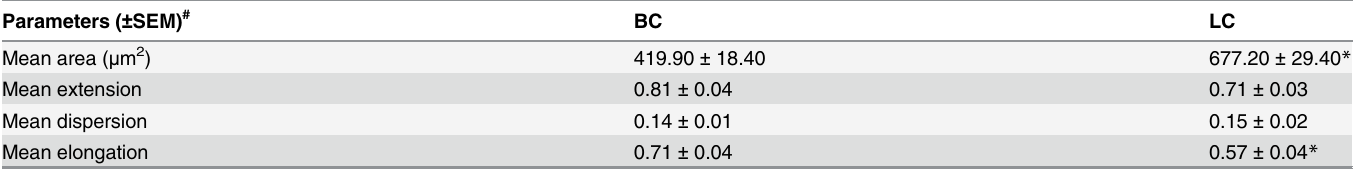
Table 1. Parameters characterizing the morphology of blebbing and lamellipodia forming cell.